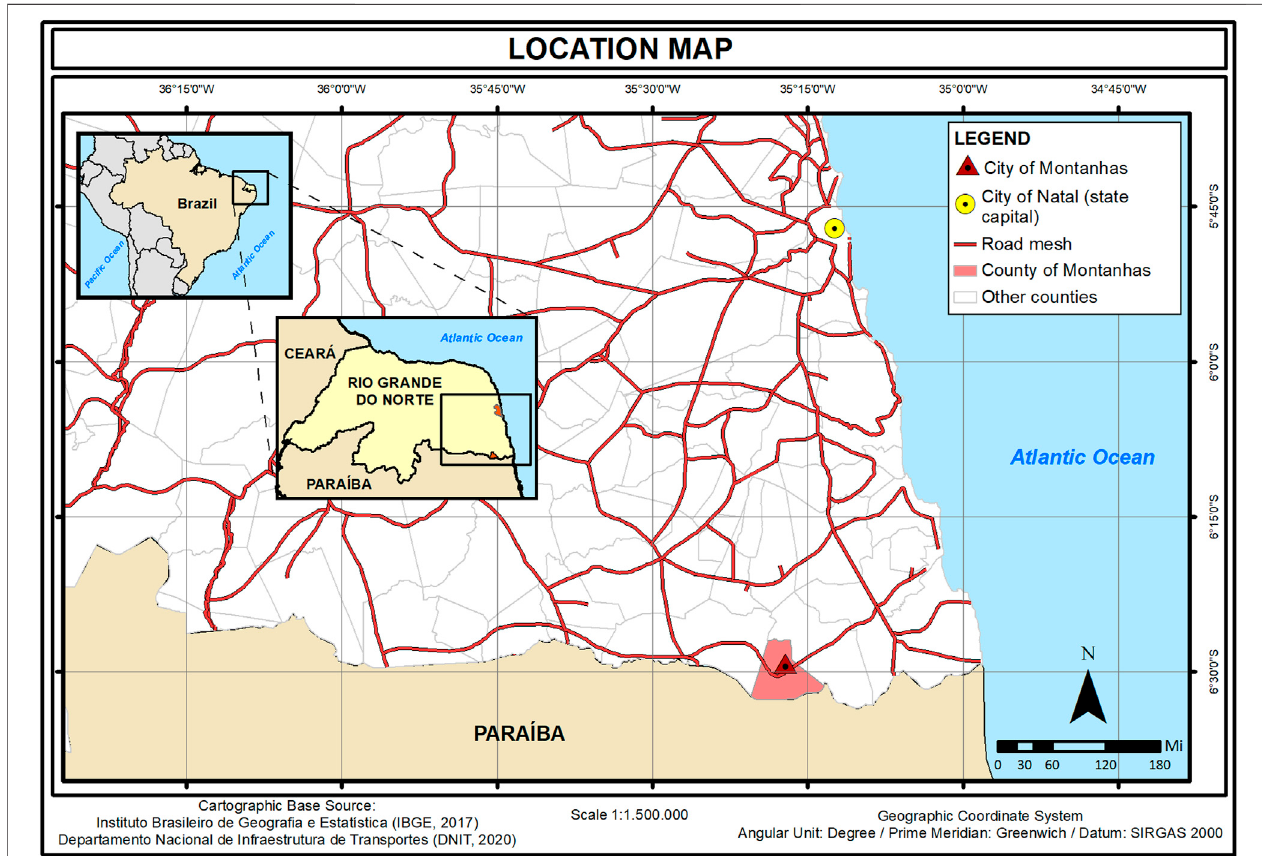
FIGURE1| LocationmapfromthecityofMontanhasinthestateofRioGrandedoNorte(RN)inthenortheastofBrazil.Patientsreceivemedicalcare60milesaway in the city of Natal (capital of the state).